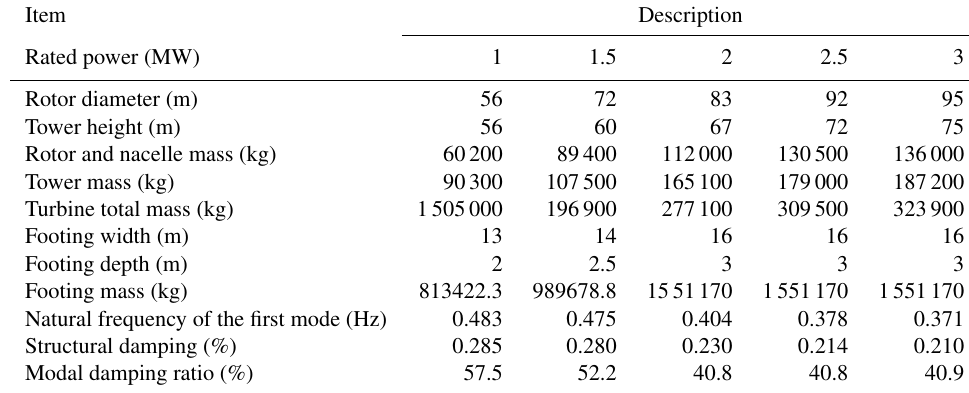
Table 8. The outline of the piled-foundation-supported wind turbines with different rated powers.